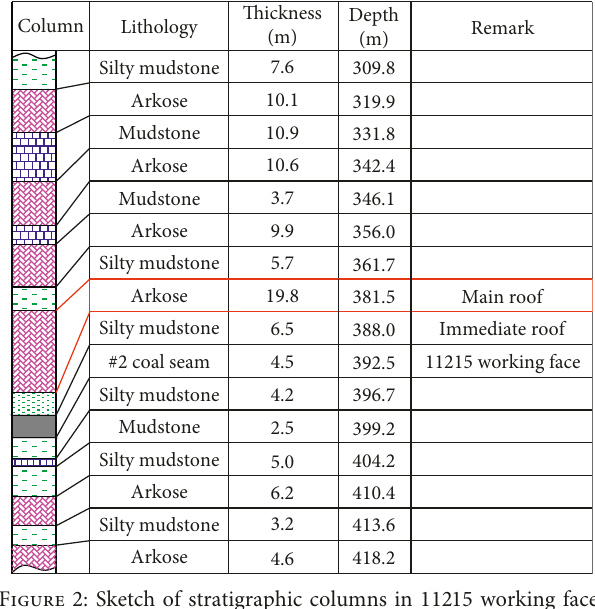
Figure 2: Sketch of stratigraphic columns in 11215 working face.